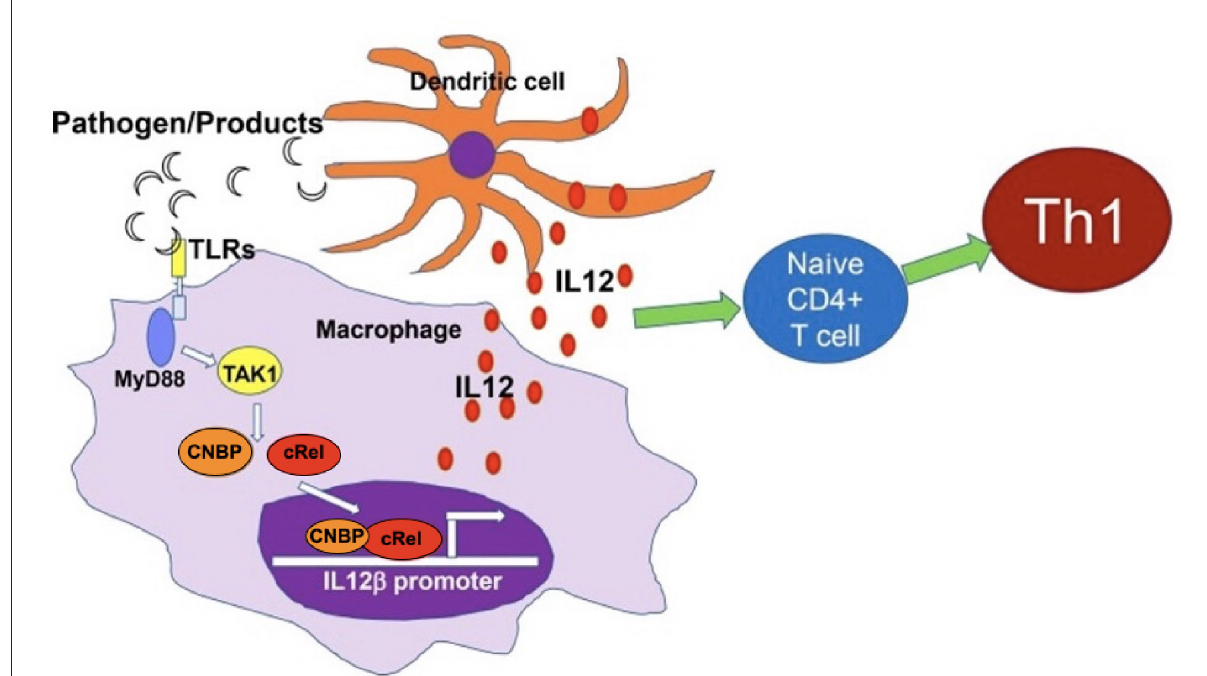
FIGURE1 CNBP regulates IL-12 β gene transcription, IL-12 production, and Th1 immunity. CNBP resides in the cytosol of macrophages and translocates to the nucleus in response to diverse microbial pathogens and pathogen-derived products through the TLR-MyD88-IRAK-TAK1 signaling pathway. CNBP has a selective ability to control the activation of c-Rel, a key driver of IL-12 β gene transcription. The nuclear translocation and DNA binding activity of c-Rel require CNBP. Furthermore, CNBP itself binds the IL-12 β promoter. Figure reprinted and adapted with permission of the author and publisher and used under CC BY-NC-SA